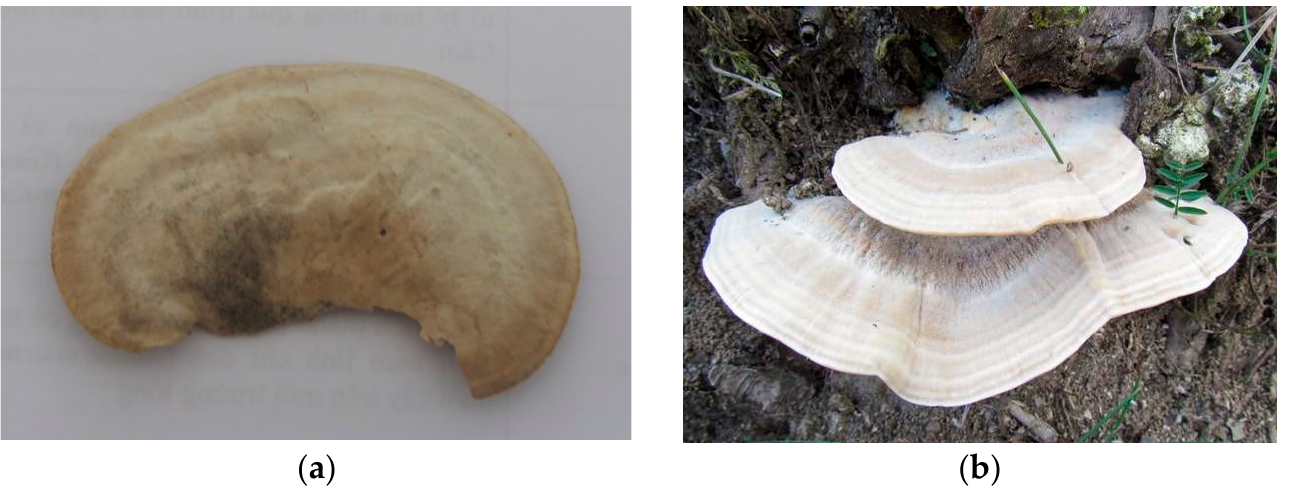
Figure 1. Fruiting bodies of ( a ) T. cubensis and ( b ) T. suaveolens .